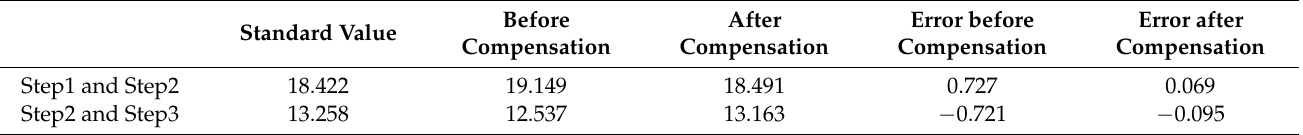
Table 1. Measurement precision of step distance before and after calibration (unit: mm).